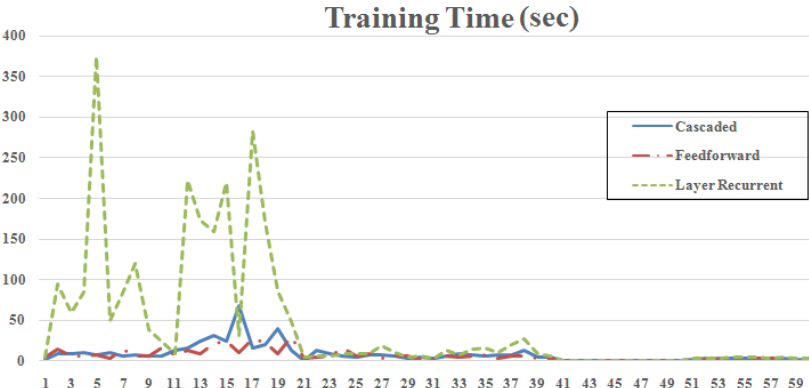
Figure 7. Number of iterations (epochs) taken by each model to converge.